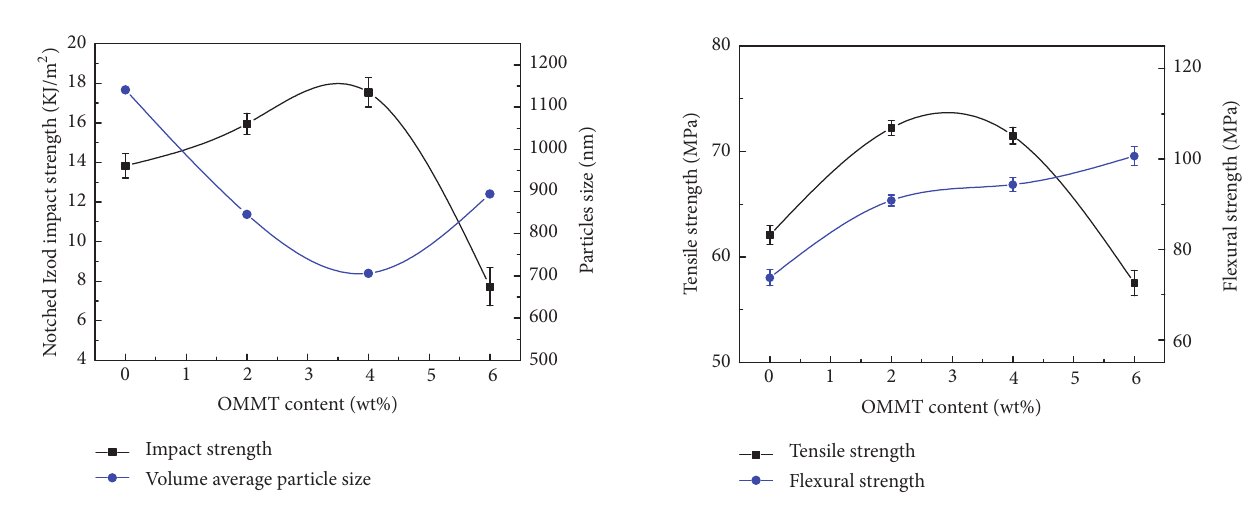
Figure 6: Tensile strengths and flexural strengths of PPO/PA66 nanocomposites with addition of OMMT.